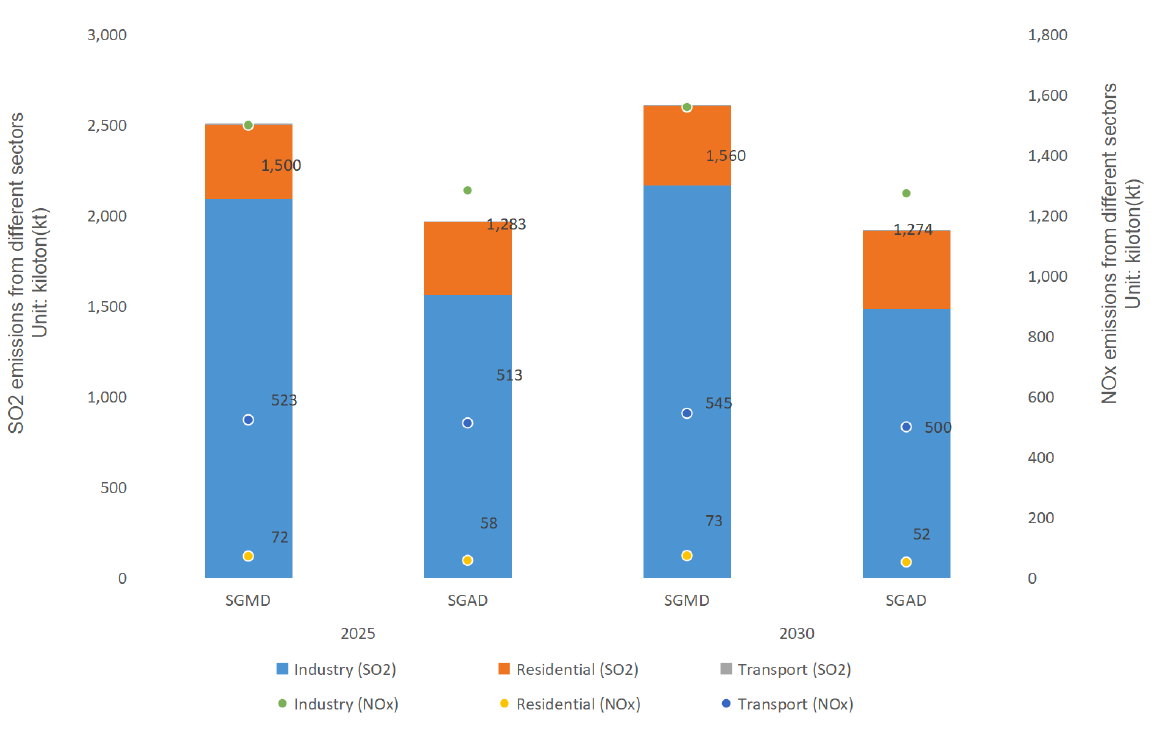
Figure 10. Emissions of SO 2 and NO x from different